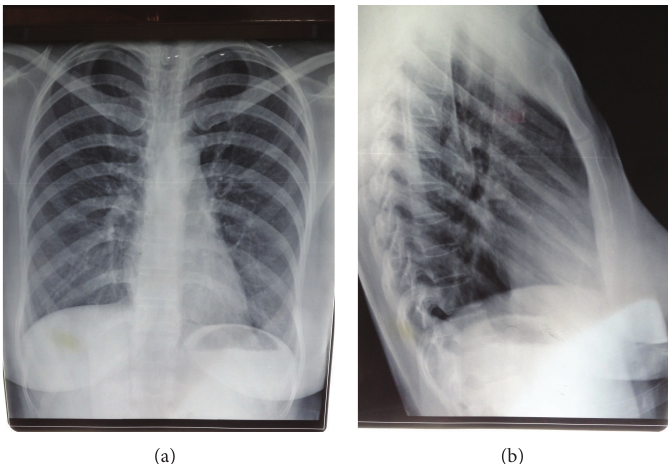
Figure 3: Posteroanterior and lateral chest radiograph, respectively, showing clear lung fields after completion of six-month antituberculous